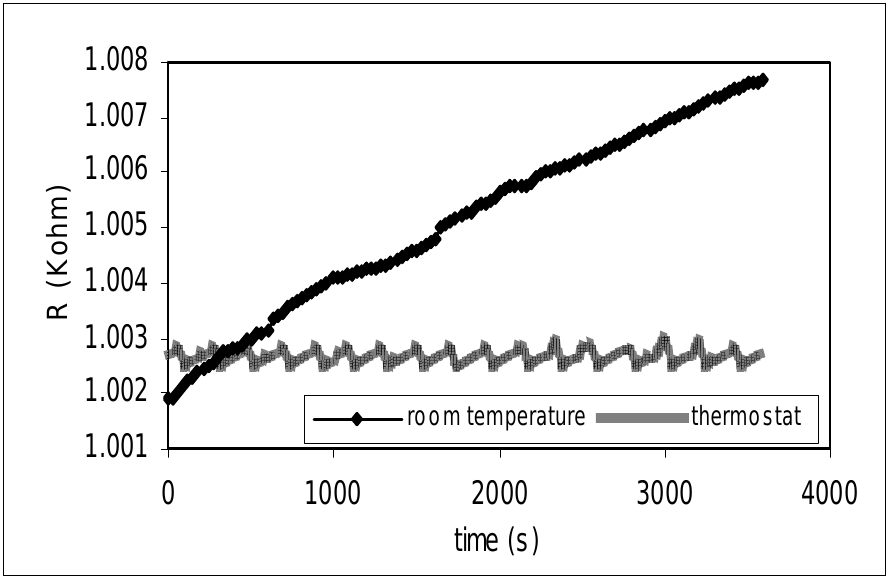
Figure 3. Stability in the Reading of Outgoing Electric Resistance of the Thermistor. Cell-Water